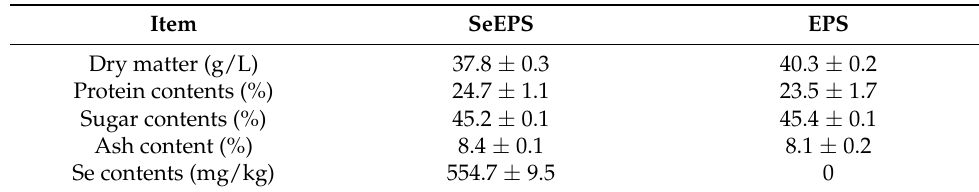
Table 1. Chemical composition of SeEPS and EPS.